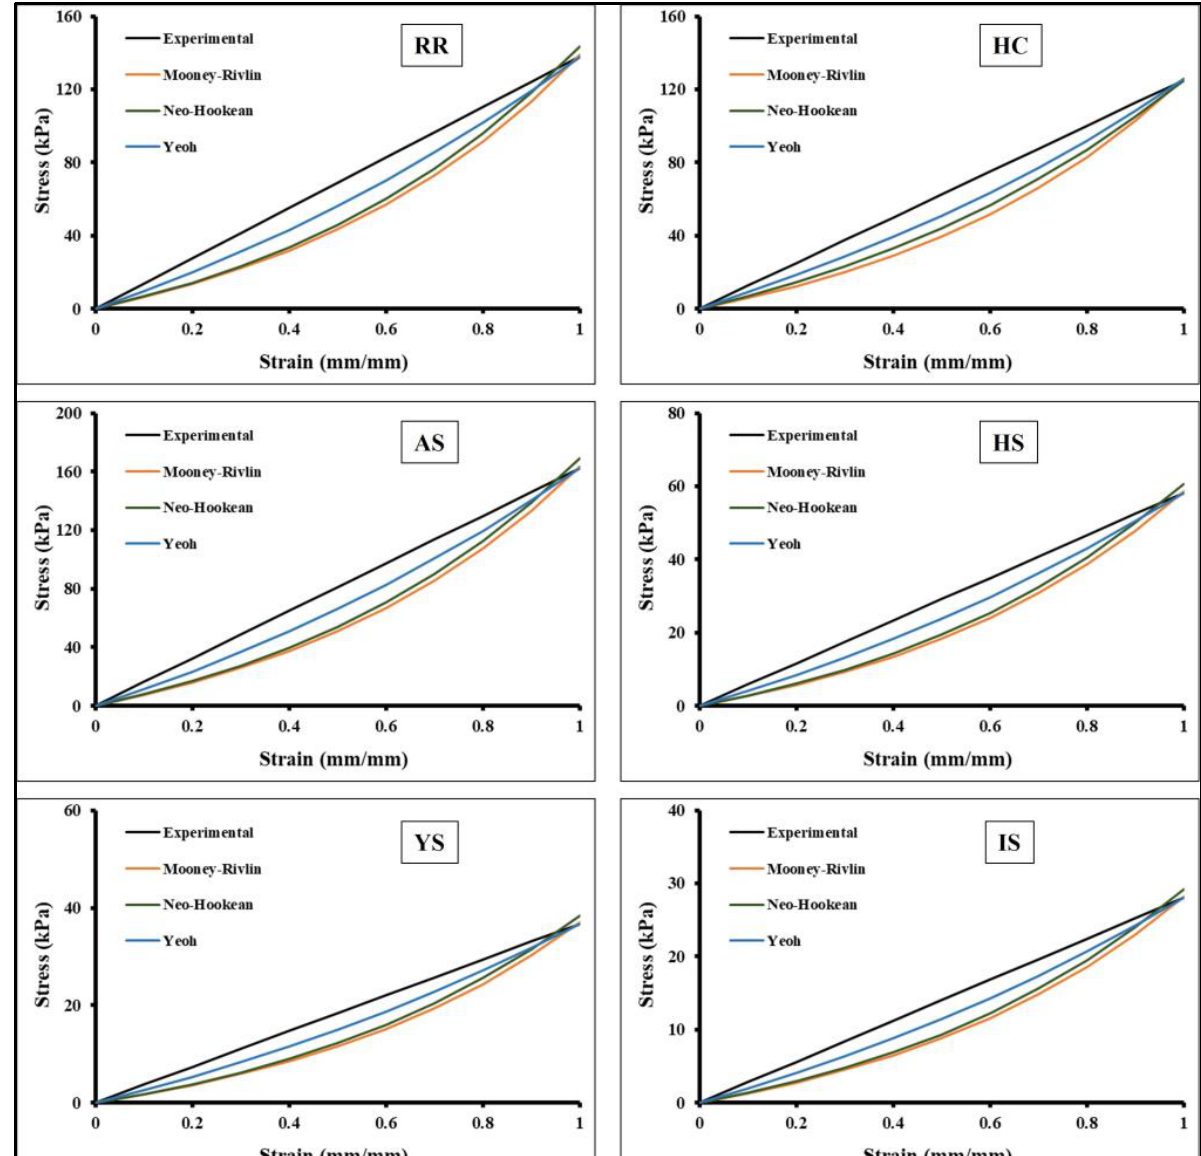
Figure 8. Different hyperelastic curve fit models with experimental results of auxetic